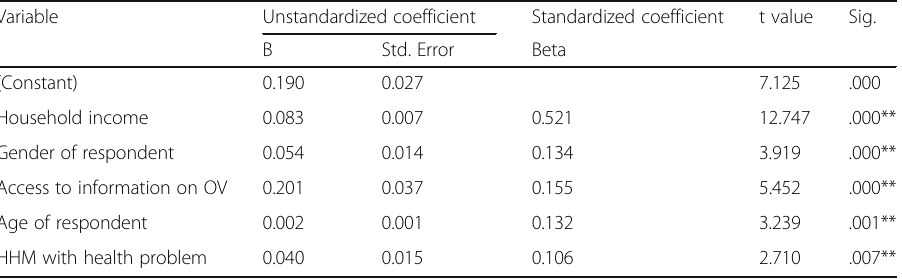
Table 4 Coefficients of Variables of factors influencing consumers ’ perception of the environmental effects of organic agriculture using Stepwise Multiple Linear Regression Model Variable